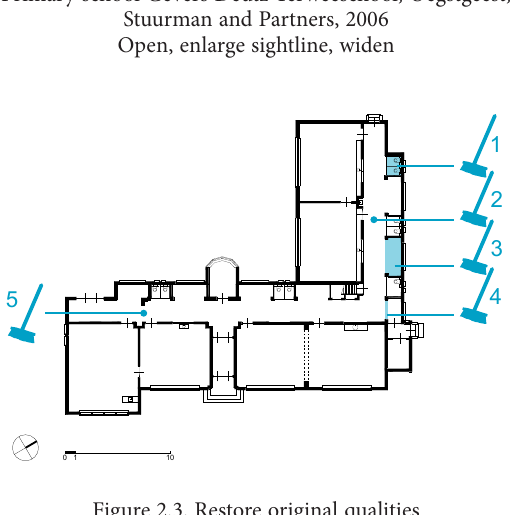
Figure 2.2. Break open